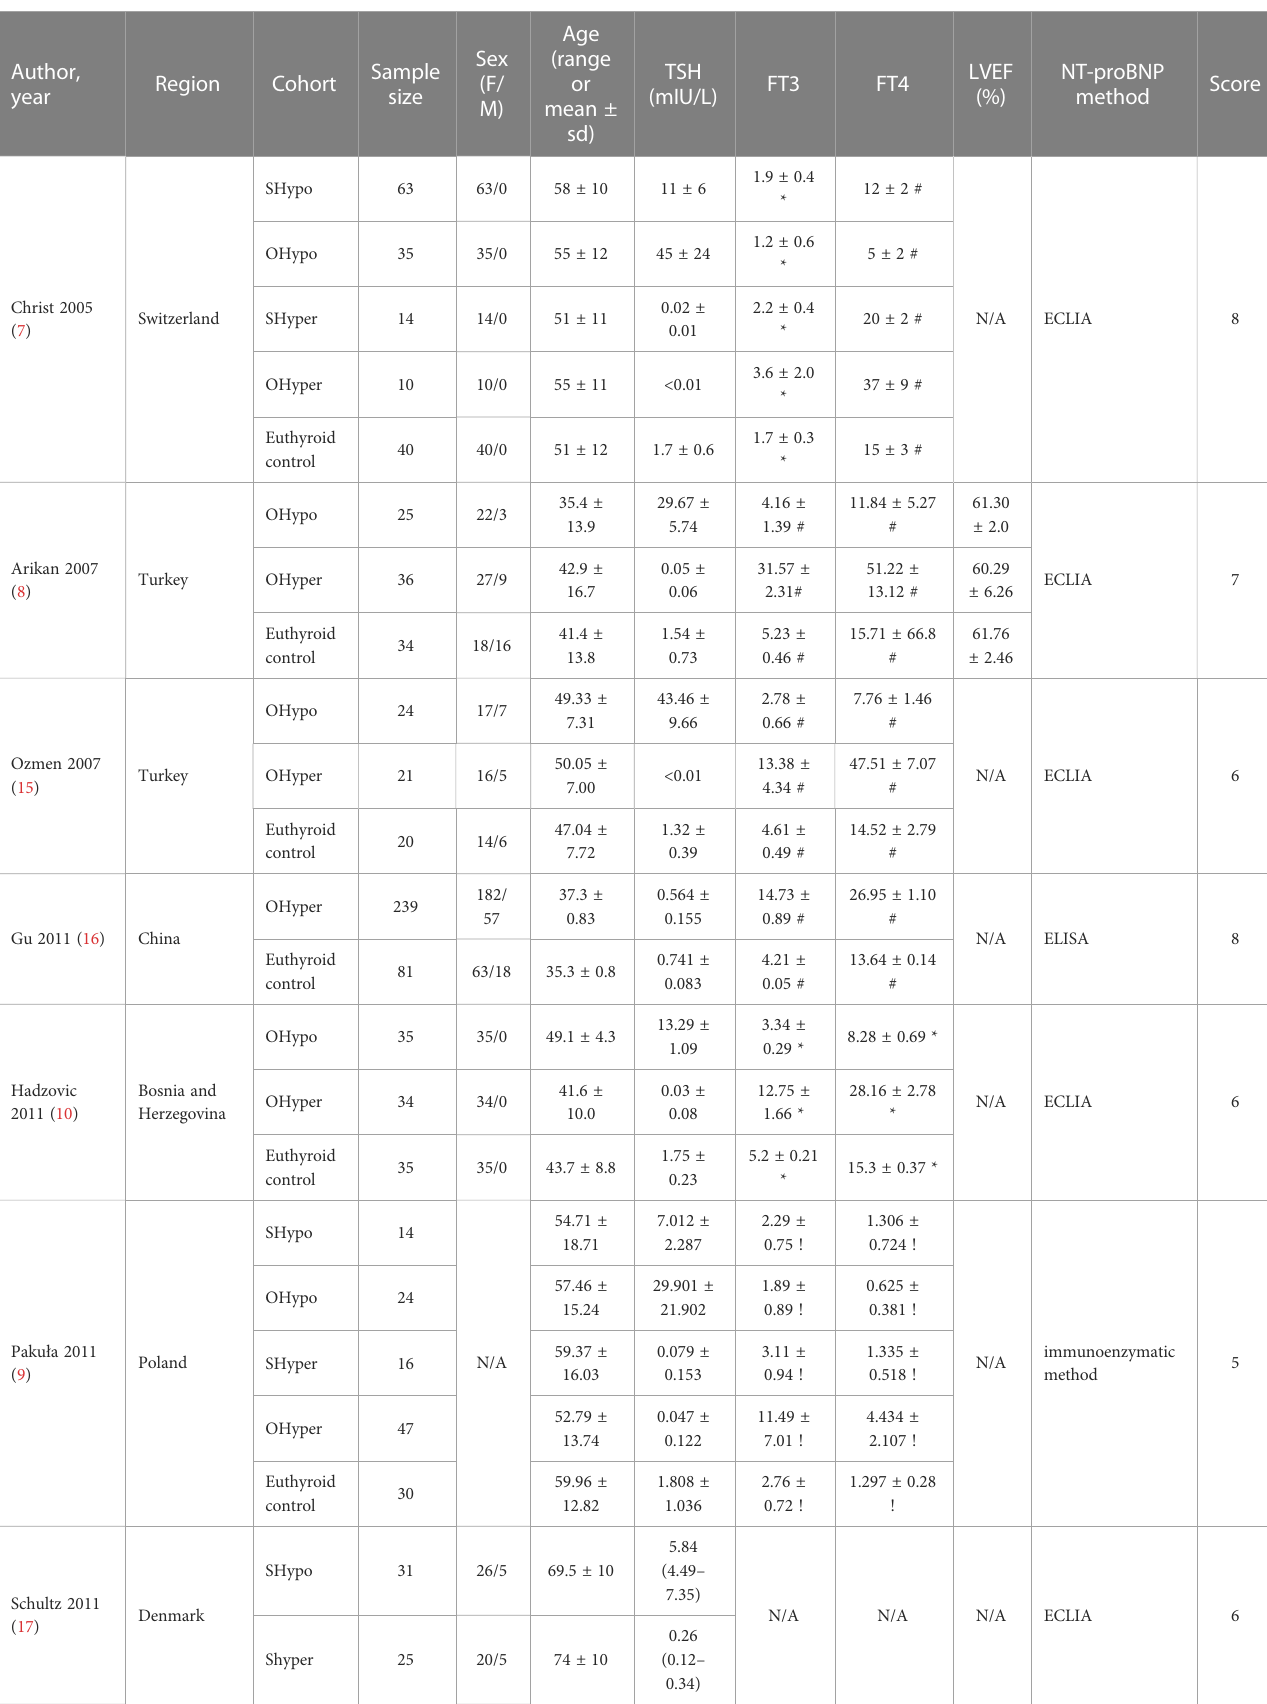
TABLE 1 General characteristics of the included studies discussing NT-proBNP levels in TD and